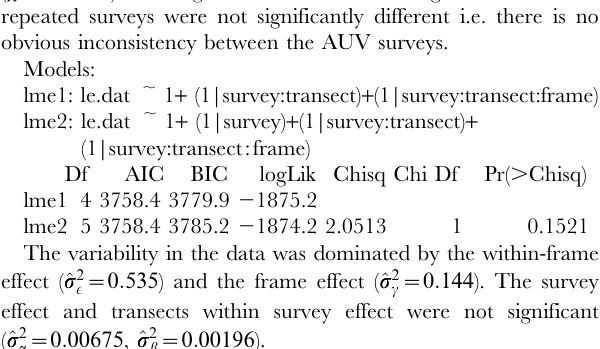
Figure 6. Known and estimated mean heights from 4 size categories of scallops planted along a inter-tidal zone for the